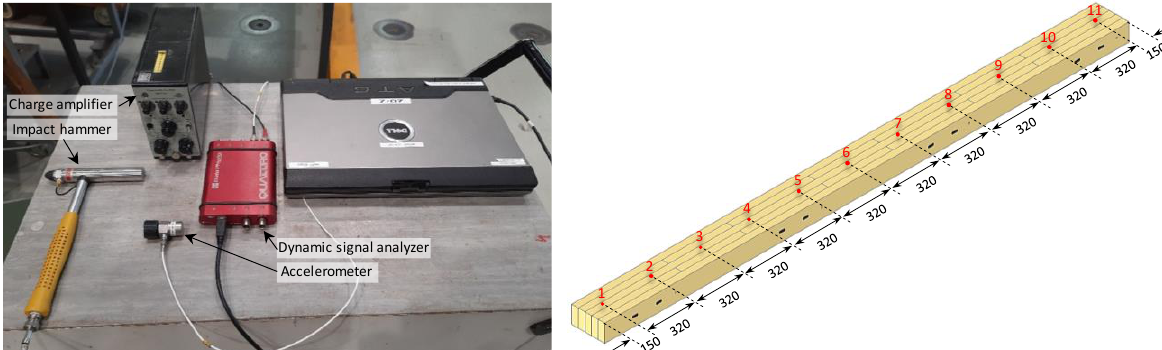
Figure 5. The vibration test instrument ( left ) and the location of the impact points on the large-scale DLT specimens ( right ).